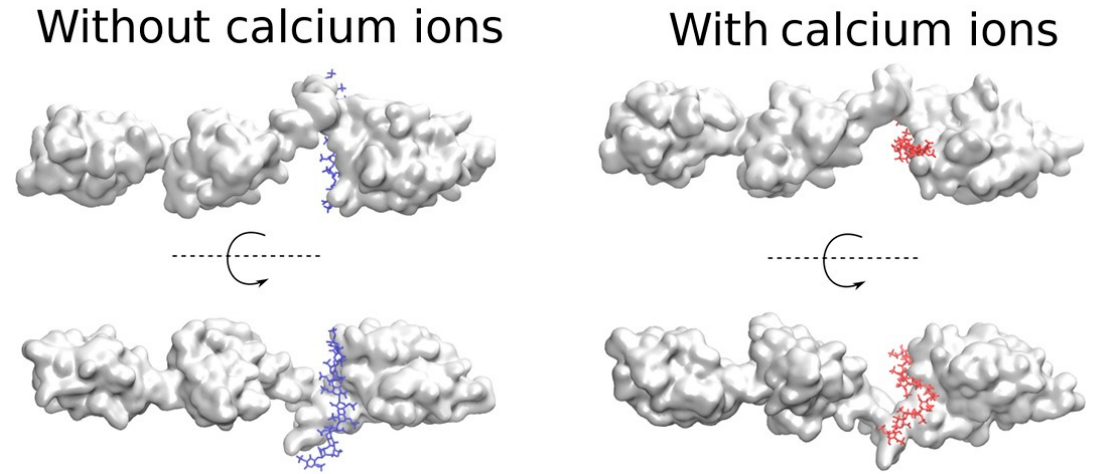
Figure 7. Molecular docking results for the models of the full PCPE-1 SAXS Model in the absence (in blue) and the presence (in red) of Ca 2+ ions and HP dp11 corresponding to the most favorable free binding energies.